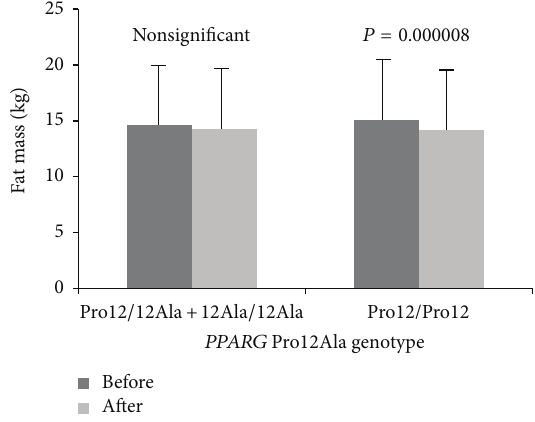
Figure 3: Changes in fat mass observed in participants ( PPARG 12Ala carriers versus Pro12 homozygotes) before and after the completion of 12-week training program.